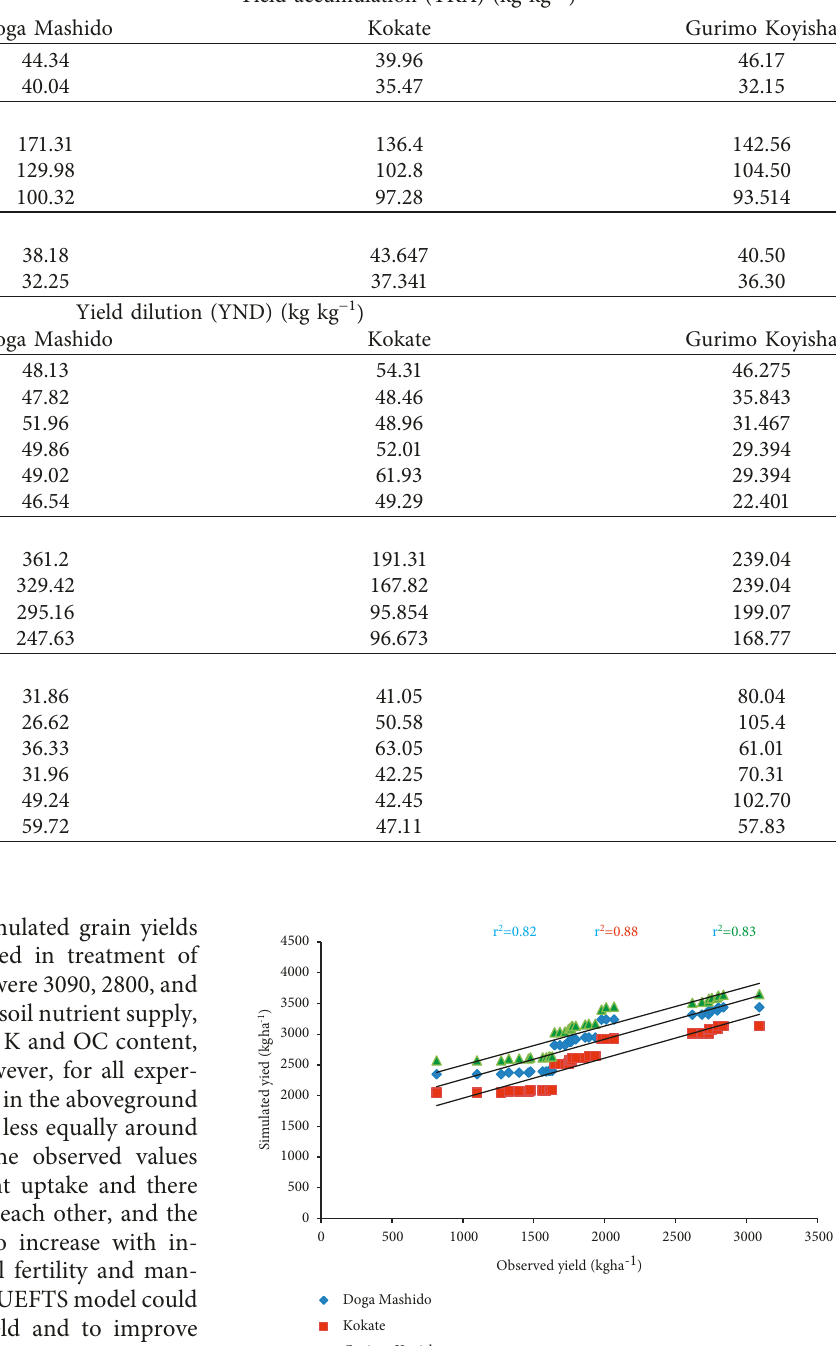
Table 3: Model parameterization by maximum yield accumulation and dilution in treatment and experimental sites. Treatment